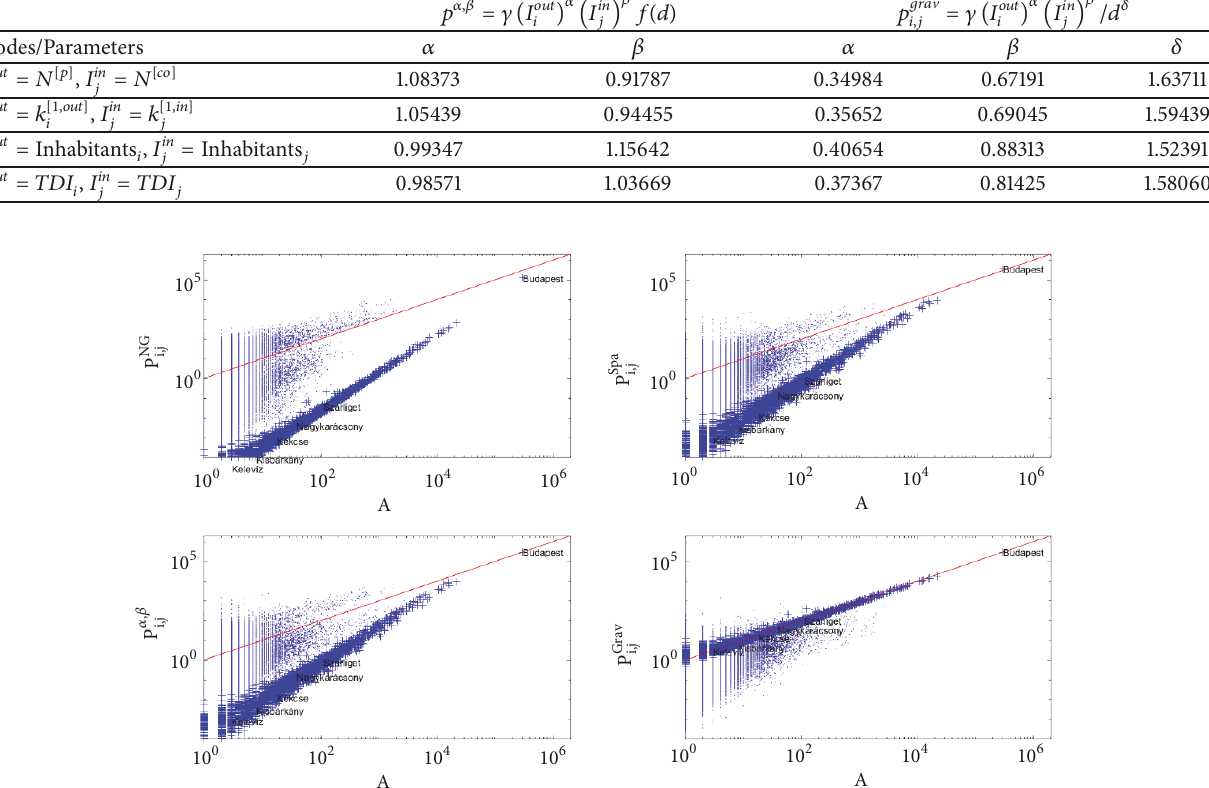
𝑝 𝛼,𝛽 = 𝛾 (𝐼 𝑜𝑢𝑡 ) 𝛼 (𝐼 𝑖𝑛 ) 𝛽 𝑓(𝑑) 𝑖 𝑗